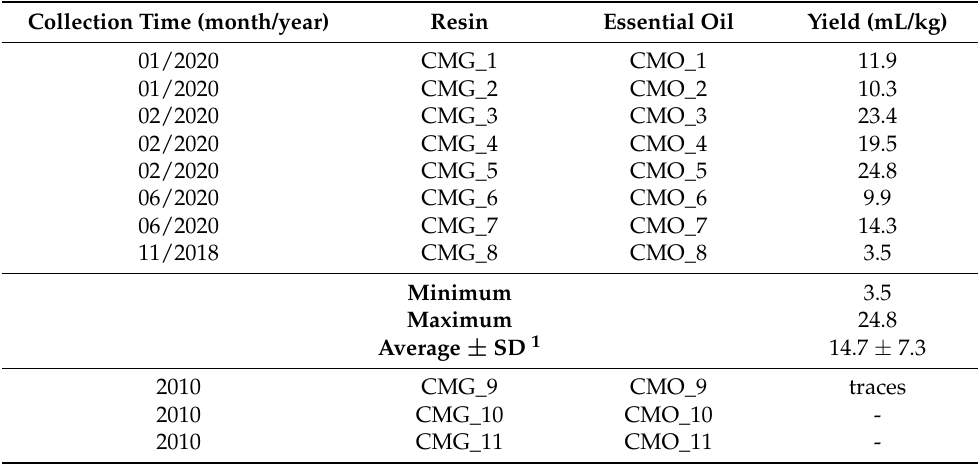
Table 1. Hydrodistillation yields, performed according to the Ph. Eur. instructions.